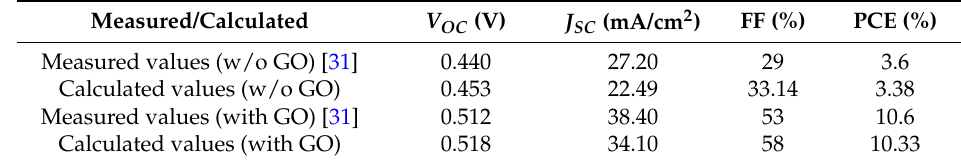
Figure 4. J–V curve for the solar cell in [31]. Black curves refer to the cell w/o graphene oxide (GO). Red curves refer to the cell with GO. ( a ) Calculated data. ( b ) Measured data that are adapted from [31], with the permission of The Royal Society of Chemistry. Table 3. Calculated vs. measured performance parameters of the solar cell reported in [31].